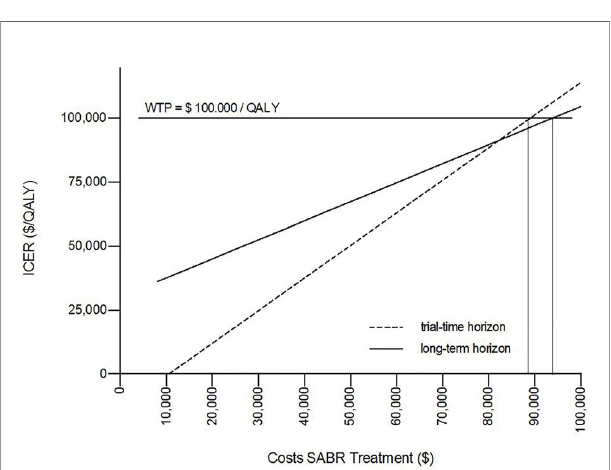
FIGURE 3 | One-way sensitivity analysis proved cost-effectiveness for SABR up to unit costs of $88,696 over the trial duration and $93,750 for long-term survival for a willingness-to-pay (WTP) threshold of